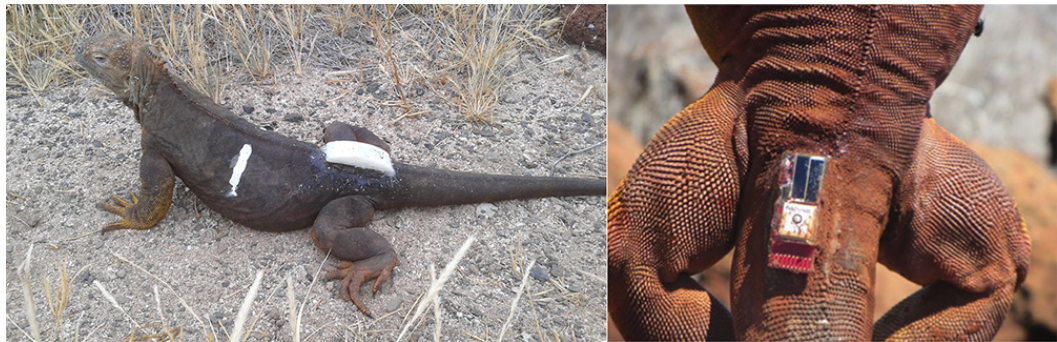
Figure 5. On the left, animal with the device glued. On the right, the attachment of the WSN on the iguana